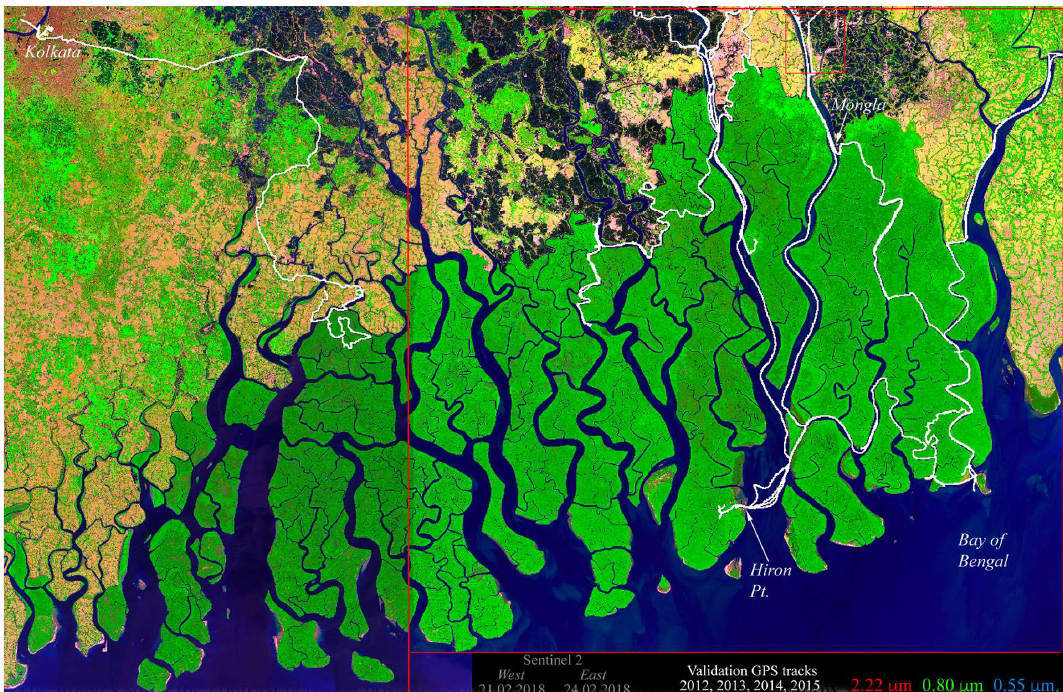
Figure 1. Index maps of the Ganges-Brahmaputra Delta ( top ) and Sundarban mangrove forest ( bottom ). Elevation map (inset) superimposed on MODIS composite shows height gradient of the forest canopy and subsidence of the polders north of the Sundarban. Sentinel 2 False color composite ( bottom ) shows current river channel network and forest canopy cover variations. Note contrast between post-monsoon rice( top ) and winter fallow ( bottom ) in agricultural areas surrounding the mangrove forest. Red box shows extent of HLS tiles used for this study. GPS tracks show locations of field